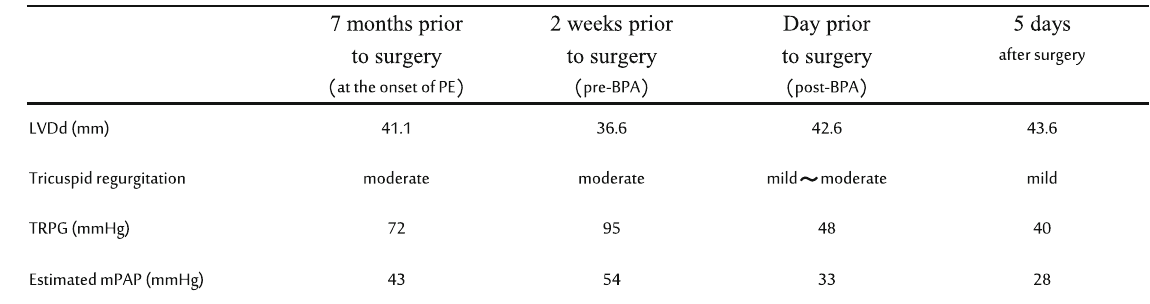
Table 1 Data from transthoracic echocardiography